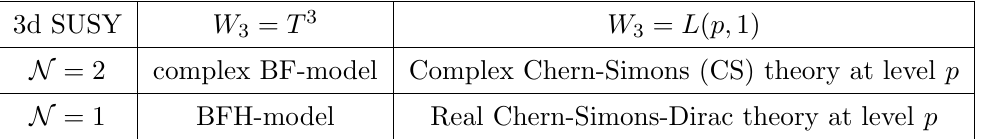
Table 2 . The N = 2 ; 1 3d-3d Correspondences, with di(cid:11)erent observables W 3 = T 3 corresponding to the Witten index, and W 3 = L ( p; 1) to the Lens space partition